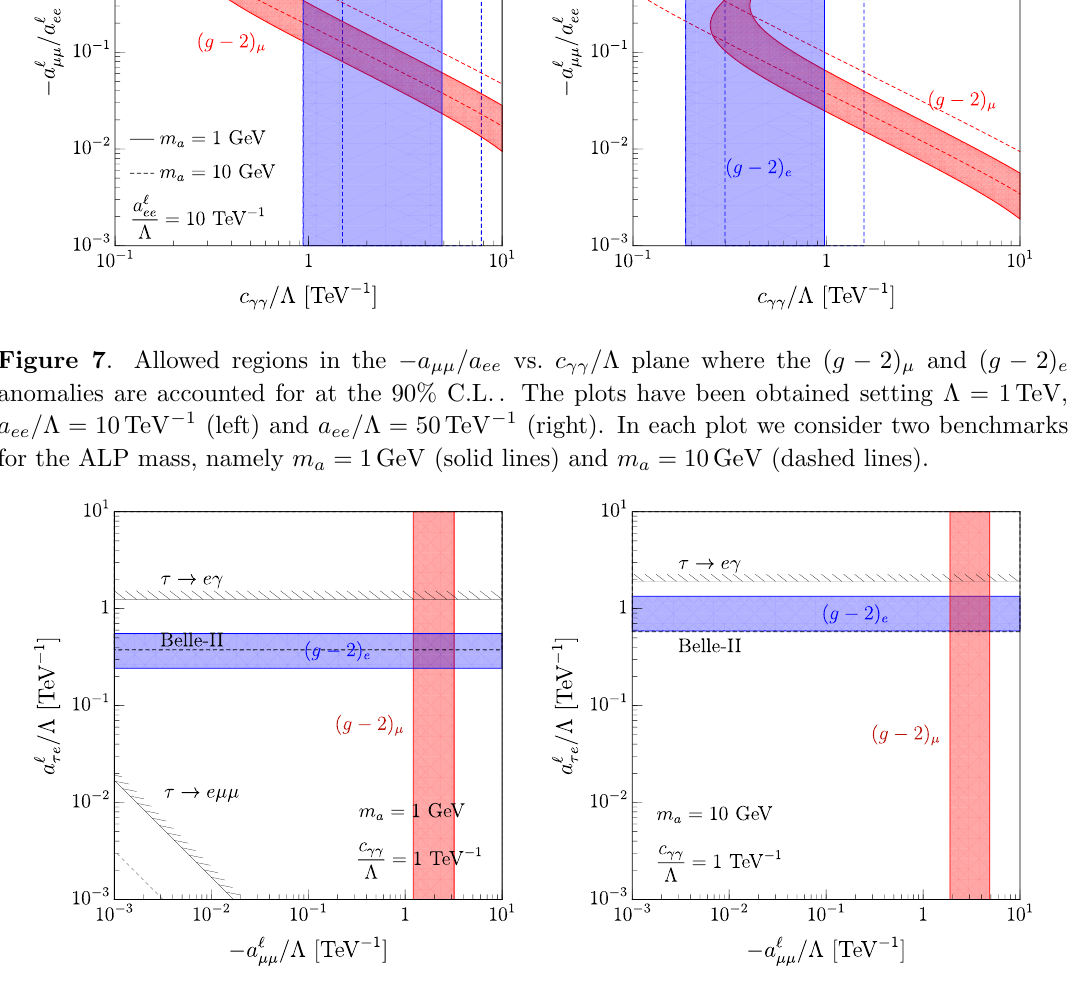
Figure 8 . Allowed regions in the a (cid:28)e = (cid:3) vs. a (cid:22)(cid:22) = (cid:3) plane where the ( g 2) (cid:22) and ( g 2) e (cid:0) (cid:0) (cid:0) anomalies are accounted for at the 90% C.L. . The plots have been obtained setting (cid:3) = 1 TeV, c (cid:13)(cid:13) = (cid:3) = 1 TeV (cid:0) 1 and m a = 1 GeV (lower left) and m a = 10 GeV (lower right). For simplicity, the other ALP couplings have been set to zero. Regions excluded by present (future) limits on ( (cid:28) e(cid:13) ) and ( (cid:28) e(cid:22)(cid:22) ) are shown by the solid (dashed) black lines, cf. table 1. B ! B ! . m 2 m < m m (left plot) tree-level e(cid:11)ects to ( (cid:28) e(cid:22)(cid:22) ) are so large that (cid:22) a (cid:28) (cid:22) (cid:0) B ! the existing limits precludes the possibility of explaining these